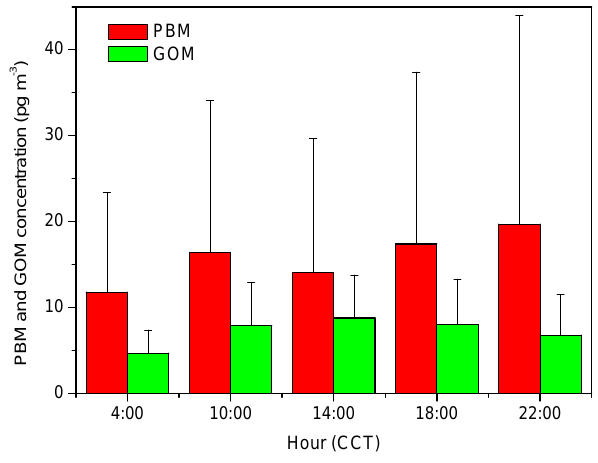
Fig. 11. Diurnal trends of PBM and GOM concentrations in ambi- ent air at Mount Waliguan Observatory